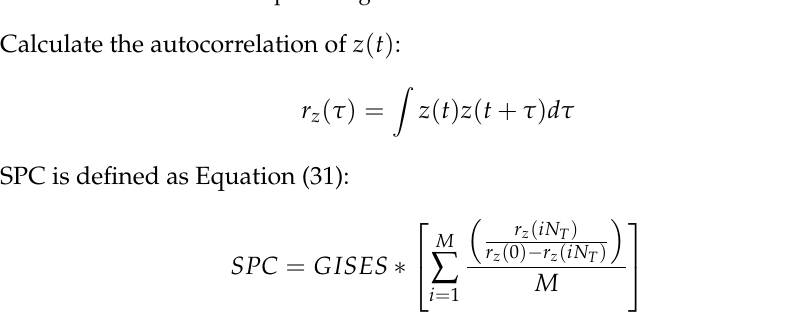
Figure 1. Flowchart of CLNGO optimizing FMD and MNAD.